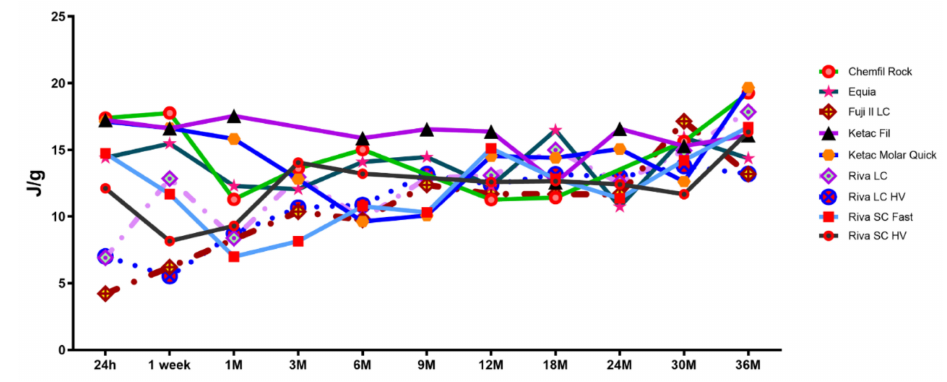
Figure 3. Mean Unbound Water Content Enthalpy (J/g); n = 12.